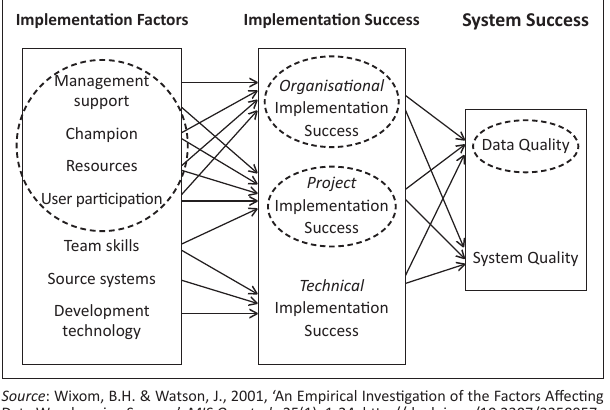
FIGURE 1: Wixom-Watson model for data warehousing success.